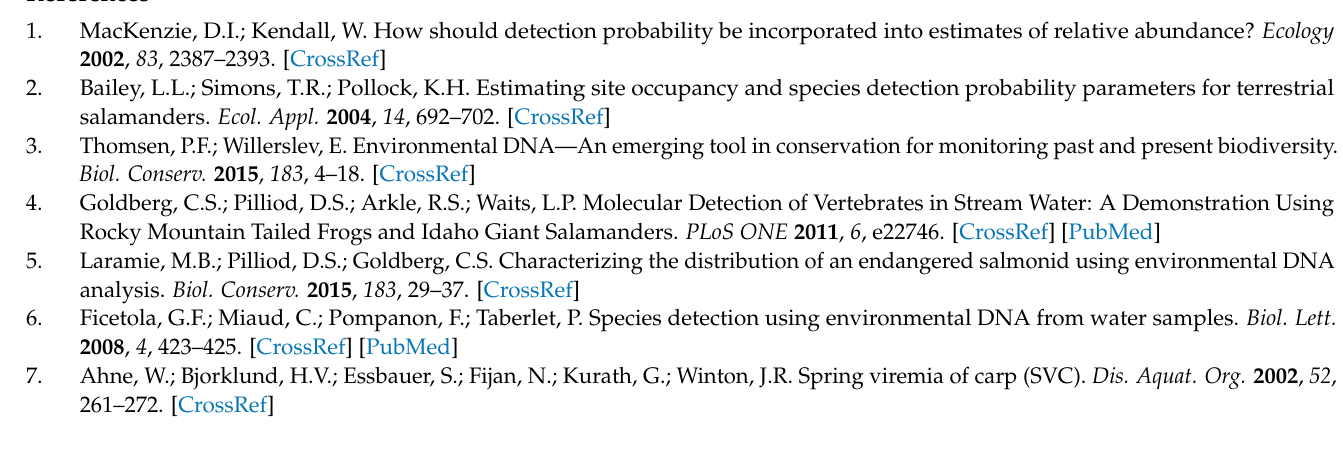
Table S5: Volumes, pore size filter, storage method and Ct value of each